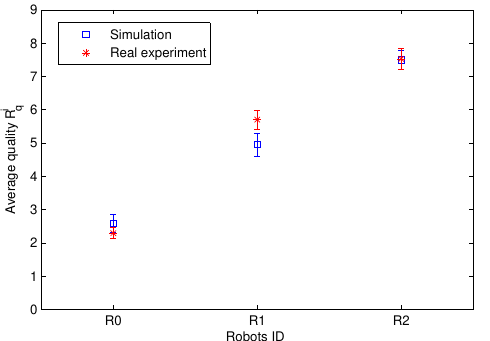
Figure 17. Average assigned task quality per Turtobot2 robot. The quality levels low (2), medium (5), and high (8) are the quality levels of robots R 0, R 1,and R 2,